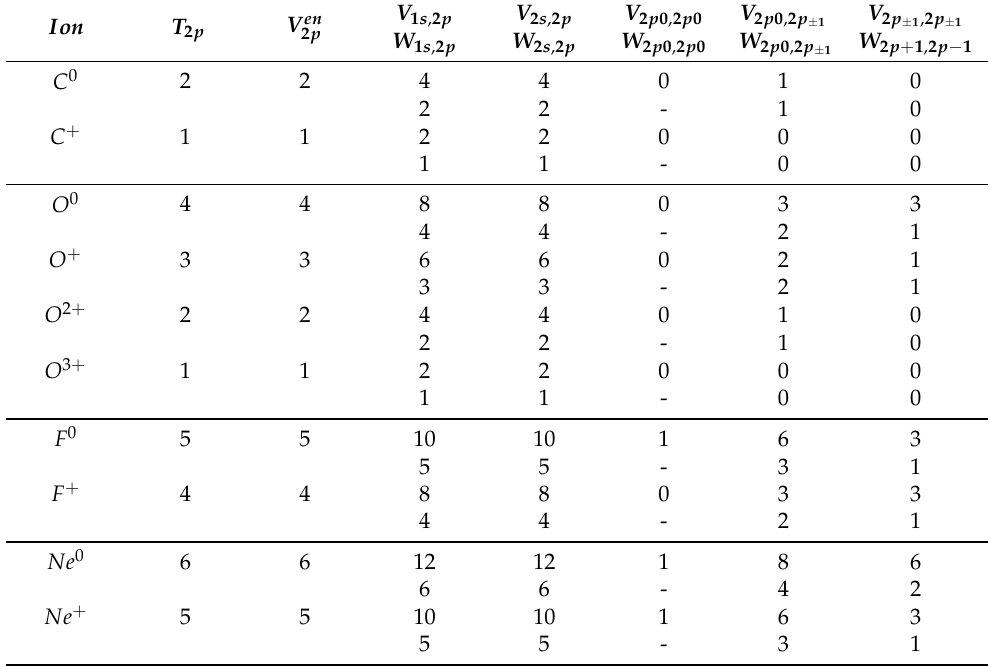
Table 1. Number of Energy Terms for various sample